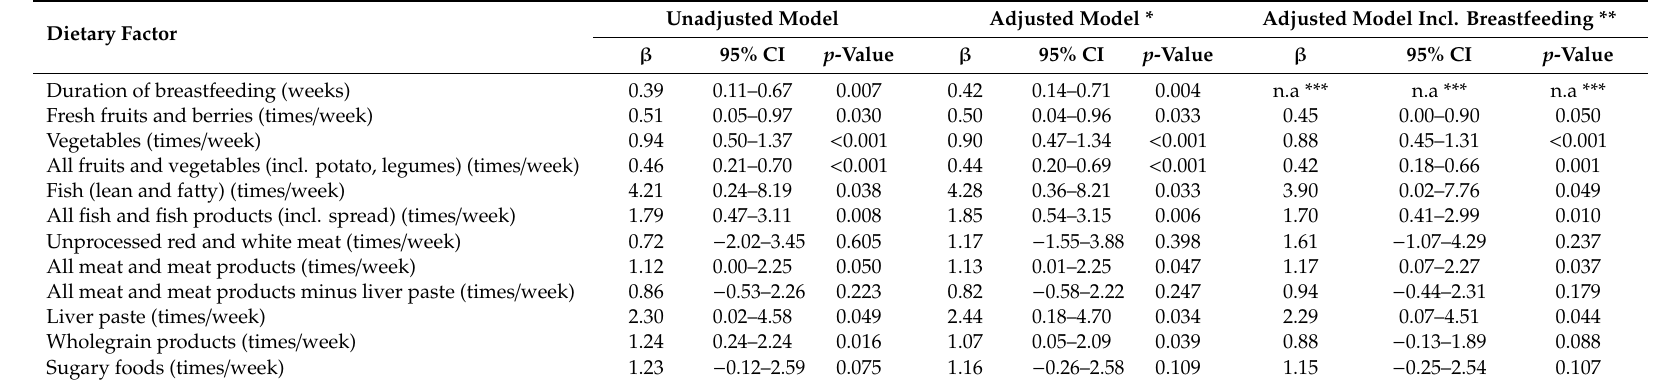
Table 4. Linear regression on associations between dietary factors and ASQ total